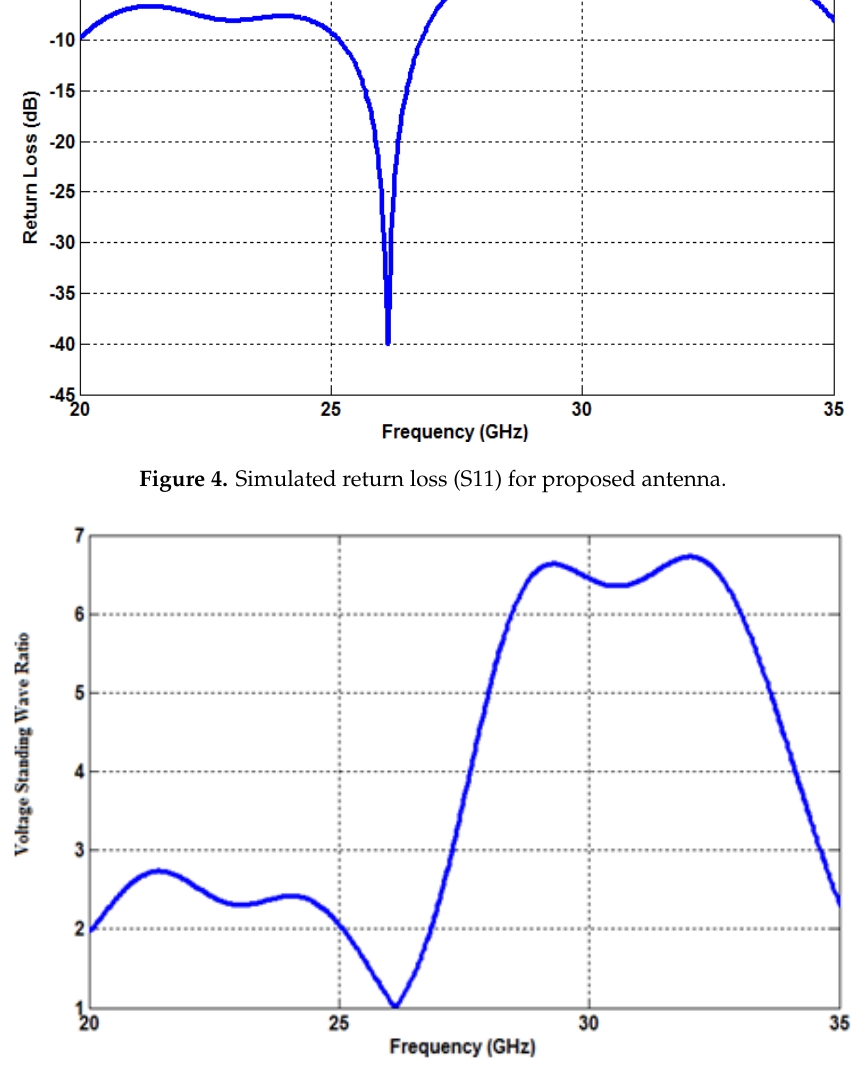
Figure 6. Simulated peak gain of the proposed antenna.